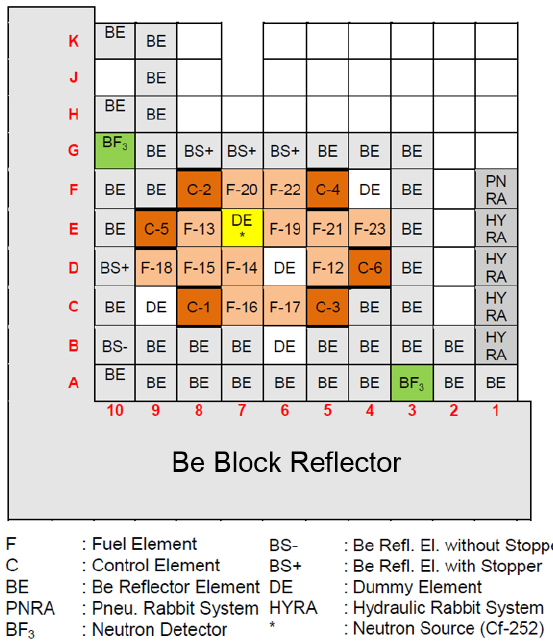
Figure 2. Full core configuration of RSG GAS first core